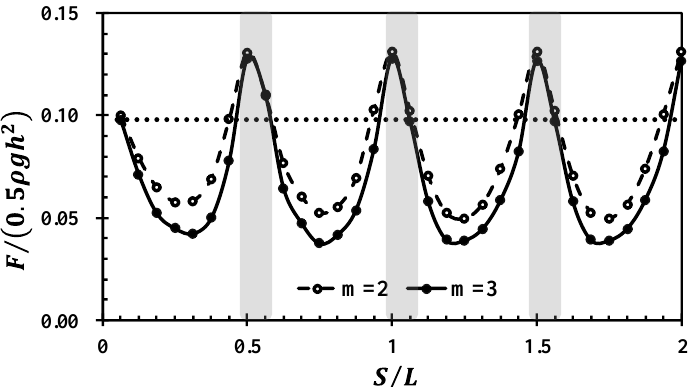
Figure 15. Variation of the pressure drag versus S / L for the different structure configurations with kd = 0.6. The dotted line is the wave force acting on the vertical breakwater directly.